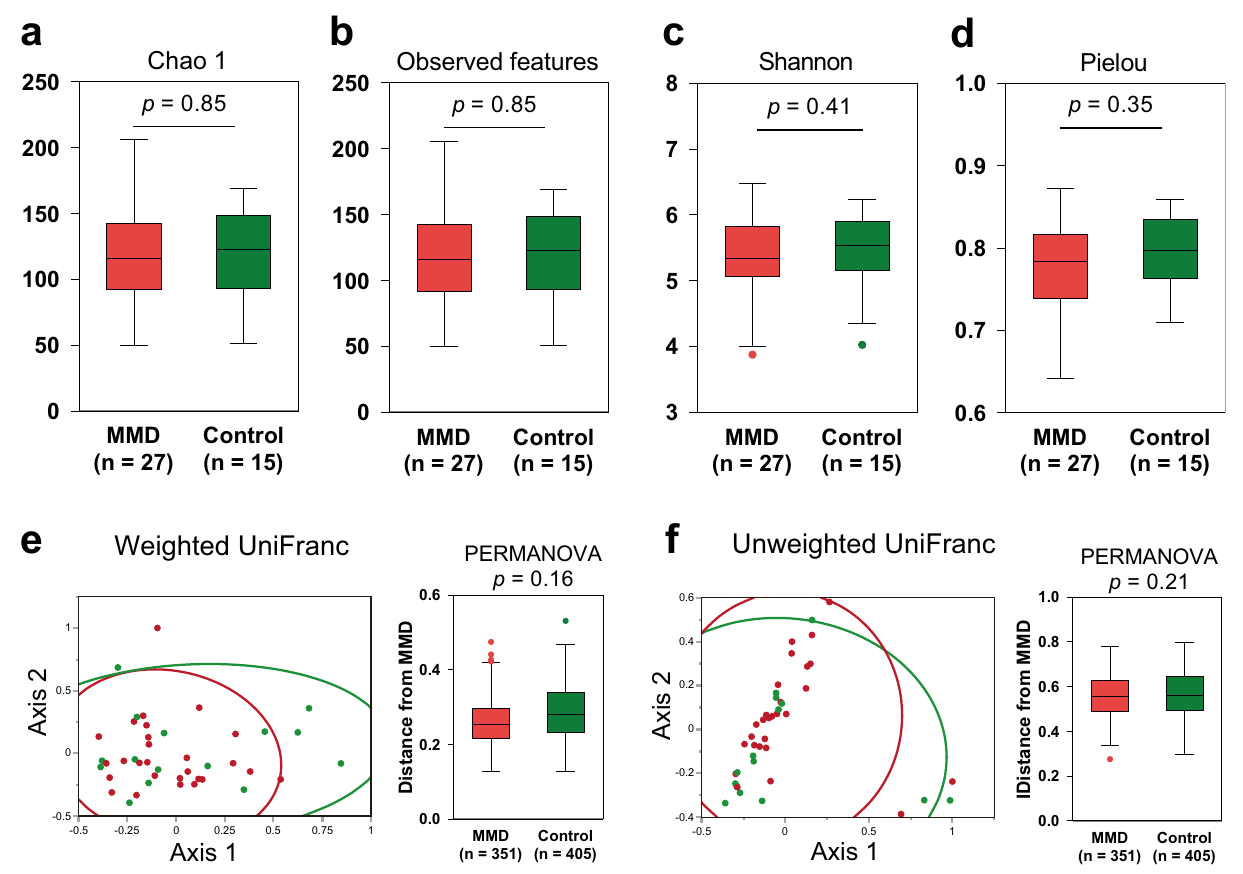
Figure 1. Alpha and beta diversity between patients with moyamoya disease (MMD) and control subjects. ( a-d ) Comparison of alpha diversity between patients with MMD and control subjects based on the Chao1, observed, Shannon, and Pielou indices. No significant difference was found in alpha diversity based on the Chao1 ( a ), observed features ( b ), Shannon ( c ) and Pielou ( d ) ( P > 0.05 by Mann–Whitney U test). Box shows interquartile range and median and whisker indicates upper and lower 95% ranges. ( e ) 2D Principal Coordinate Analysis plots of beta diversity of control subjects (green dots) and patients with MMD (red dots), and the group difference tested by PERMANOVA showed no significant difference. Ellipses indicate 95% confidence intervals. ( f ) Group difference plots in beta diversity between MMD patients and control subjects. The distances between each sample in MMD group and each other sample are shown, and n means a total number of measured